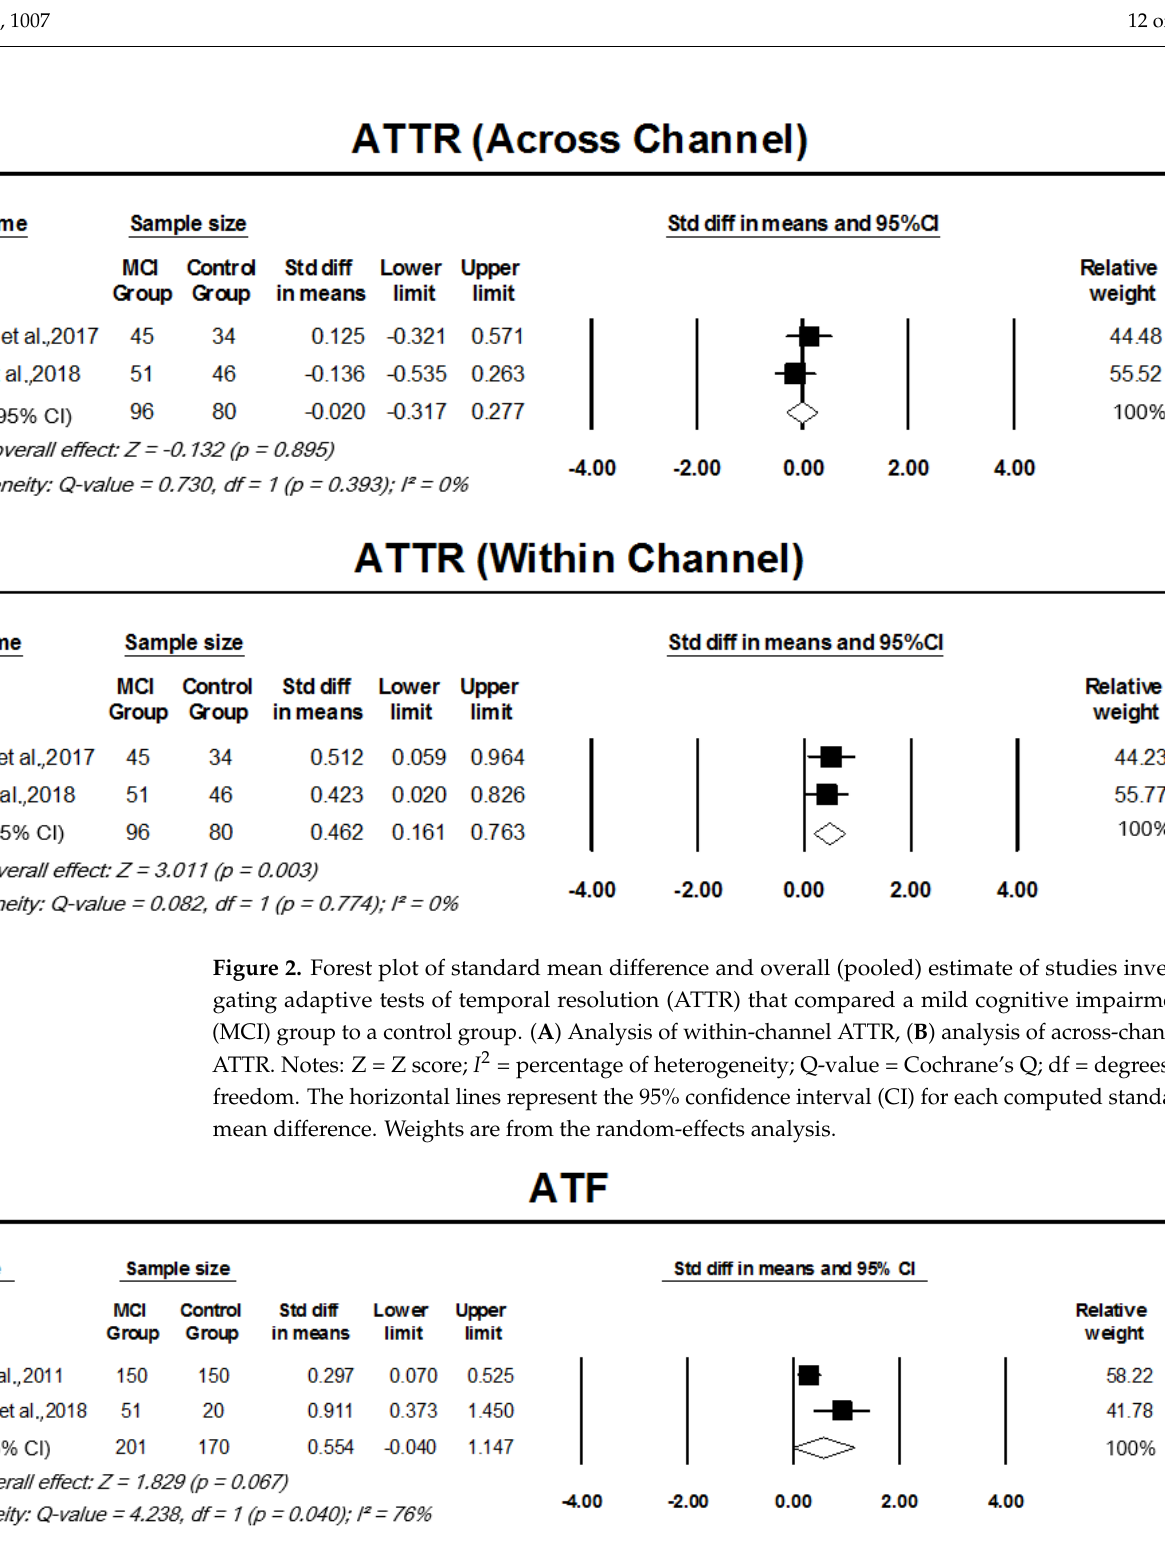
Figure 3. Forest plot of standard mean difference and overall (pooled) estimate of studies investigating auditory fusion test (ATF) that compared a mild cognitive impairment (MCI) group to a control group. Notes: Z = Z score; I 2 = percentage of heterogeneity; Q-value = Cochrane’s Q; df = degrees of freedom. The horizontal lines represent the 95% confidence interval (CI) for each computed standard mean difference. Weights are from the random-effects analysis.